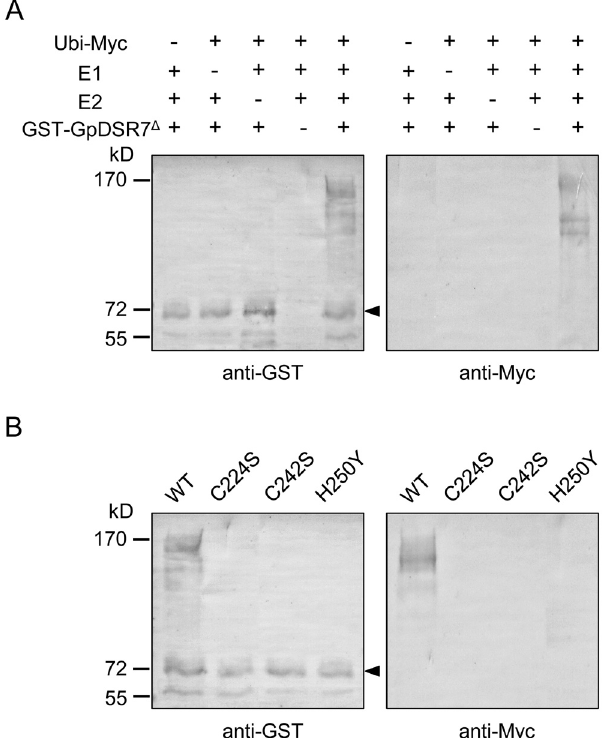
Fig 4. In vitro self-ubiquitination assay of GpDSR7. The C-terminal TM domain truncated form of GpDSR7 was defined as GpDSR7 Δ . (A) GST-tagged GpDSR7 Δ fusion protein was assayed for E3 ubiquitin ligase activity in the presence of E1, E2, and Ubi-Myc. Ubiquitinated proteins were detected by western blot analysis using an anti-GST antibody (left panel) and anti-Myc antibody (right panel). Triangles indicate non- ubiquitinated GST-GpDSR7 Δ . (B) Purified WT GST-GpDSR7 Δ and mutant proteins were used in the E3 Ub ligase enzyme